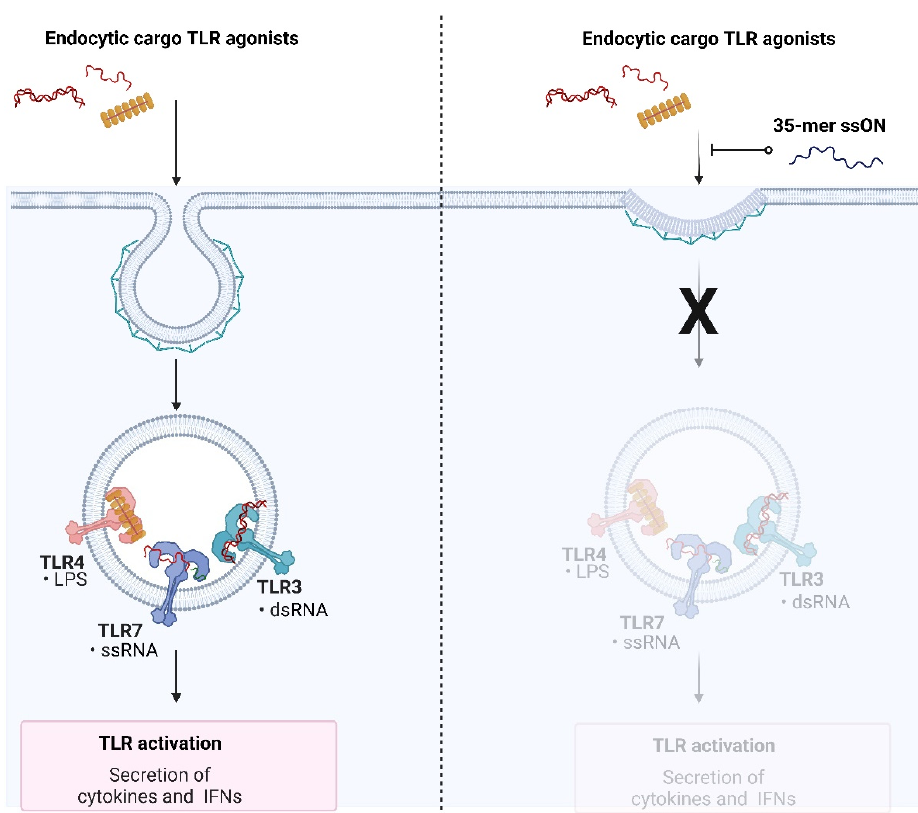
Figure 2. Schematic picture of ssON-mediated interference of endocytosis (SOMIE) modified from [15]. TLR ligands LPS, dsRNA and ssRNA are taken up through clathrin-mediated endocytosis into endosomes expressing TLR4, TLR3, and TLR7 in cells such as human moDC, which will trigger TLR activation and secretion of cytokines and IFNs (left). In the presence of 35-mer ssON in the extracellular space, clathrin-mediated endocytosis is temporarily inhibited until ssON is degraded into smaller pieces and consequently endosomal TLR 4/3/7 activation is blocked in moDC (right). Created with BioRender.com.